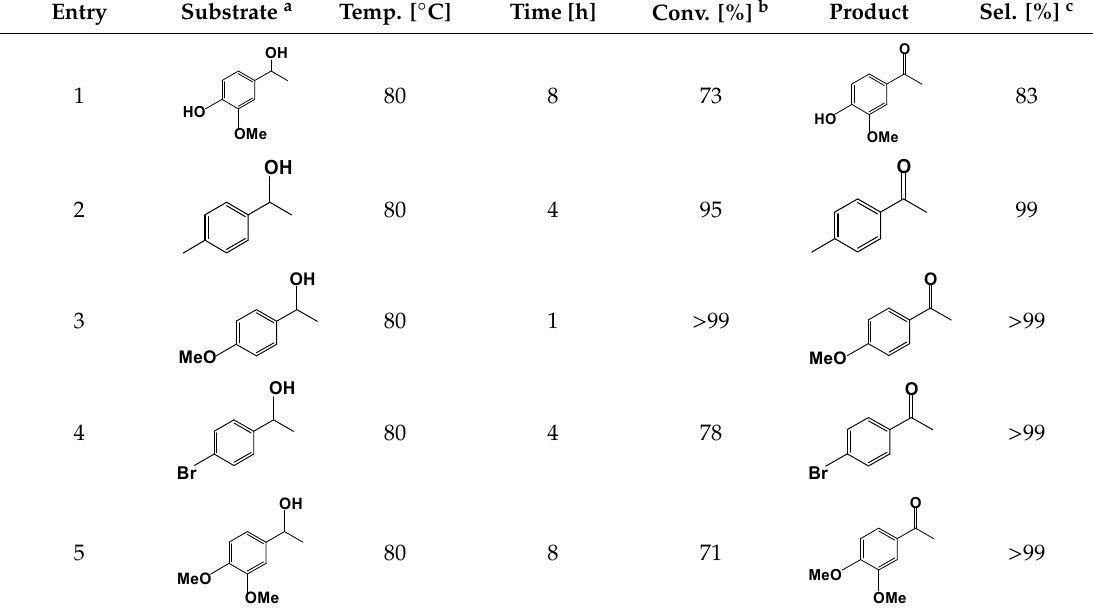
Table 3. Aerobic oxidation of benzylic alcohols over Au/meso-Fe 2 O 3 with air. Entry Substrate a Temp. [°C] Time [h]